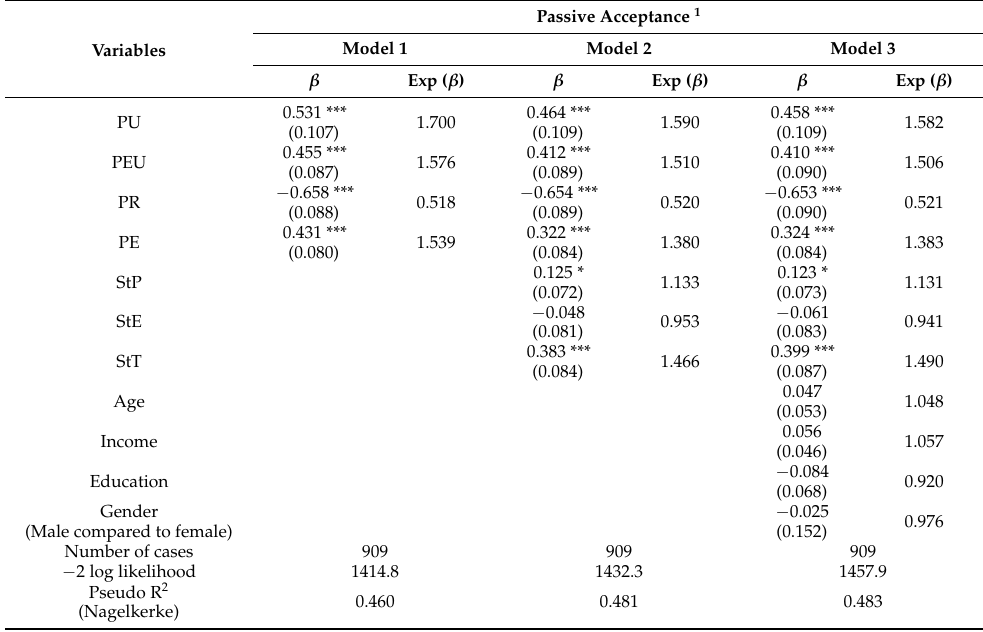
Table 2. Results for ordered logistic model (passive acceptance).